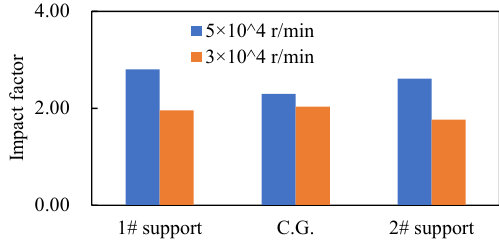
Figure 19. Impact factors at different speeds.